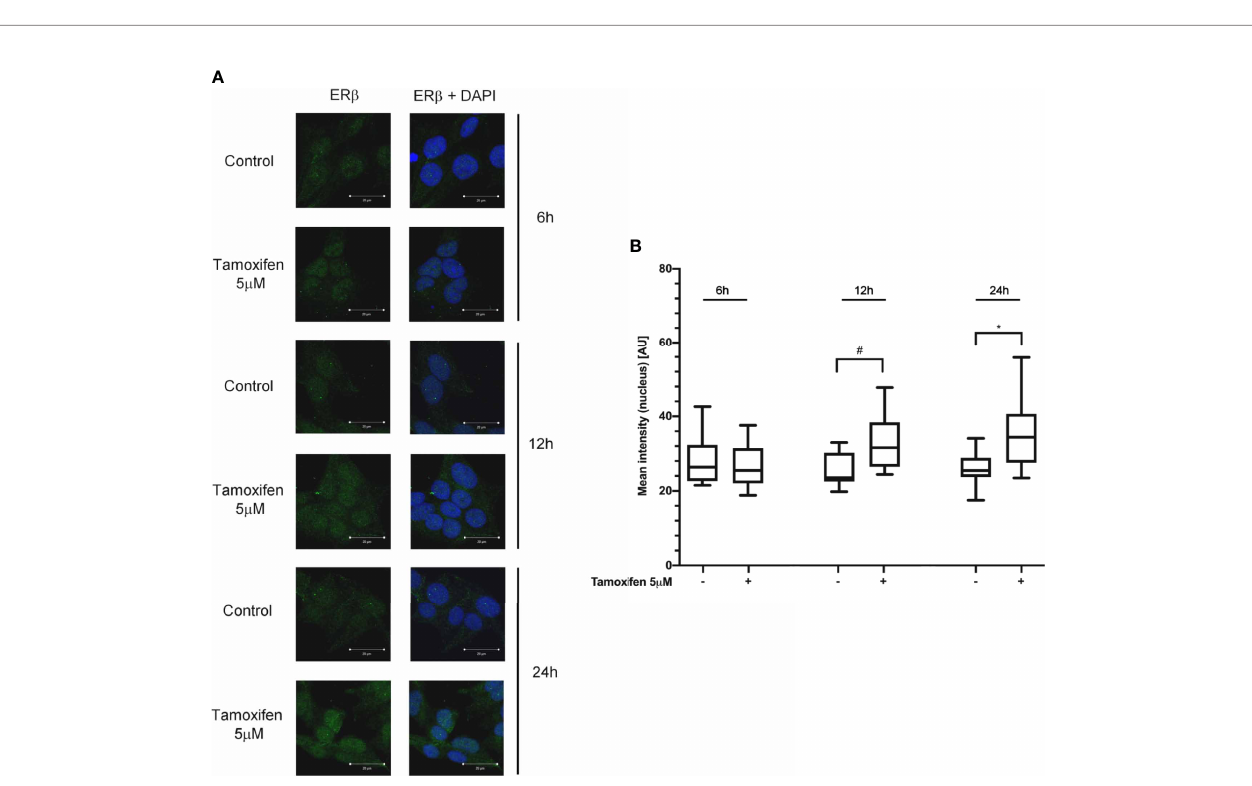
FIGURE 3 | Tamoxifen exposure selectively modi fi ed the ER intracellular localization in NCI-H295R cells. (A) Cells were treated for different times with tamoxifen IC 50 value. Slides were observed by a LSM 880 Zeiss confocal laser microscope or by a LSM 510 Zeiss confocal laser microscope (Carl Zeiss with 40× magni fi cation. Images were then reconstructed using Zeiss ZEN 2.3 Imaging Software (Carl Zeiss). On the left the ER- b staining, on the right ER- b + DAPI staining. (B) The speci fi c mean fl uorescence intensity of the pixels of acquired images was quanti fi ed using ZEN Black software (Carl Zeiss). Several fi elds, randomly chosen, were acquired and then analyzed for each experimental condition. Quanti fi ed analysis was conducted by GraphPad Prism 5.02 software. *P < 0.0001 vs ctrl; # P < 0.01 vs